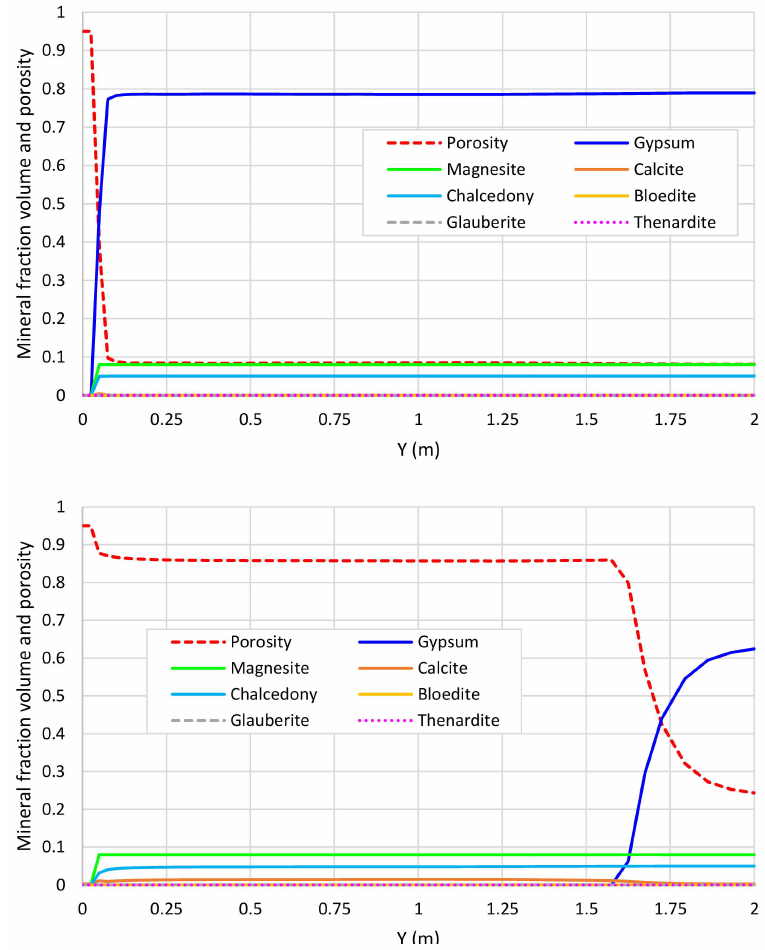
Figure 5. Computed mineral volume fractions and porosity along a vertical line at x = 1.7 m after 100 years ( top ) and 1000 years ( bottom ) of simulation in scenario